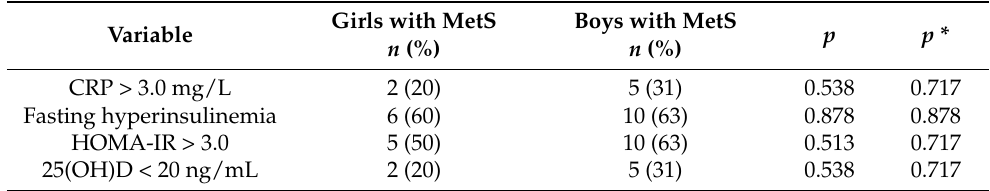
Table 2. Percentage occurrence of increased values of biomarkers associated with MetS and decreased 25(OH)D in girls and boys with MetS.